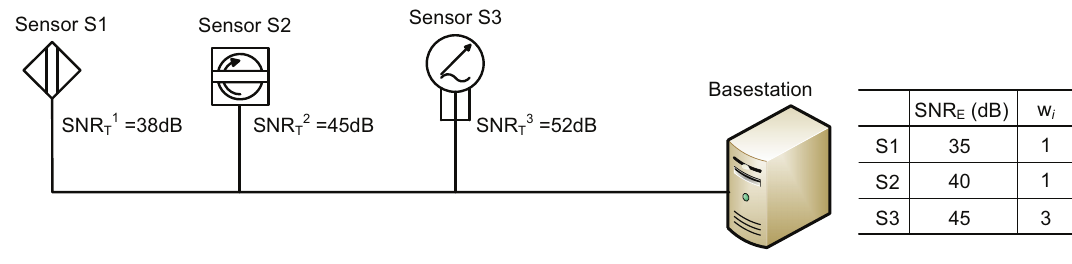
Figure 3. SNR values in an illustrative sensor